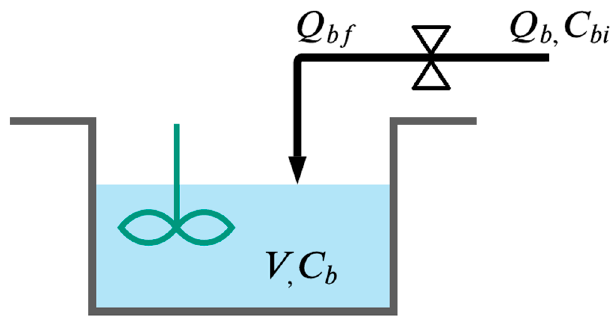
Figure 1. Schematic diagram of the system.